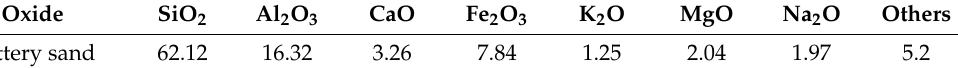
Table 2. Chemical composition of pottery sand (%).